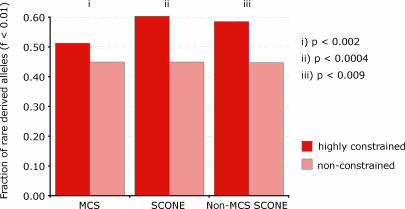
Rare Derived Allele Frequency in Conserved versus Nonconserved SitesPositions are partitioned according to (i) ENCODE MCS elements for all ENCODE positions, (ii) SCONE conservation score for all ENCODE positions, and (iii) SCONE conservation score for all ENCODE positions outside of MCS elements. p-Values are calculated using Fisher's exact test.